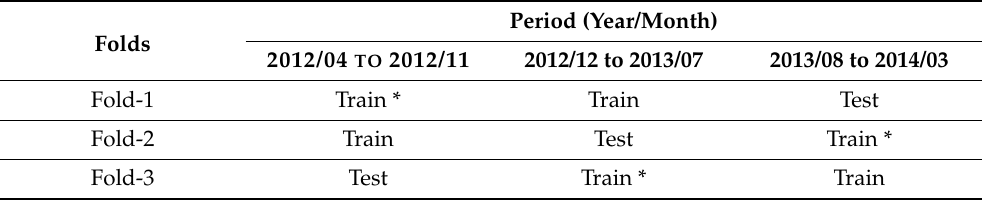
Table 1. Dataset split strategy (3-fold) adopted in this study. Folds Fold-1 Fold-2 Fold-3 Test Train *